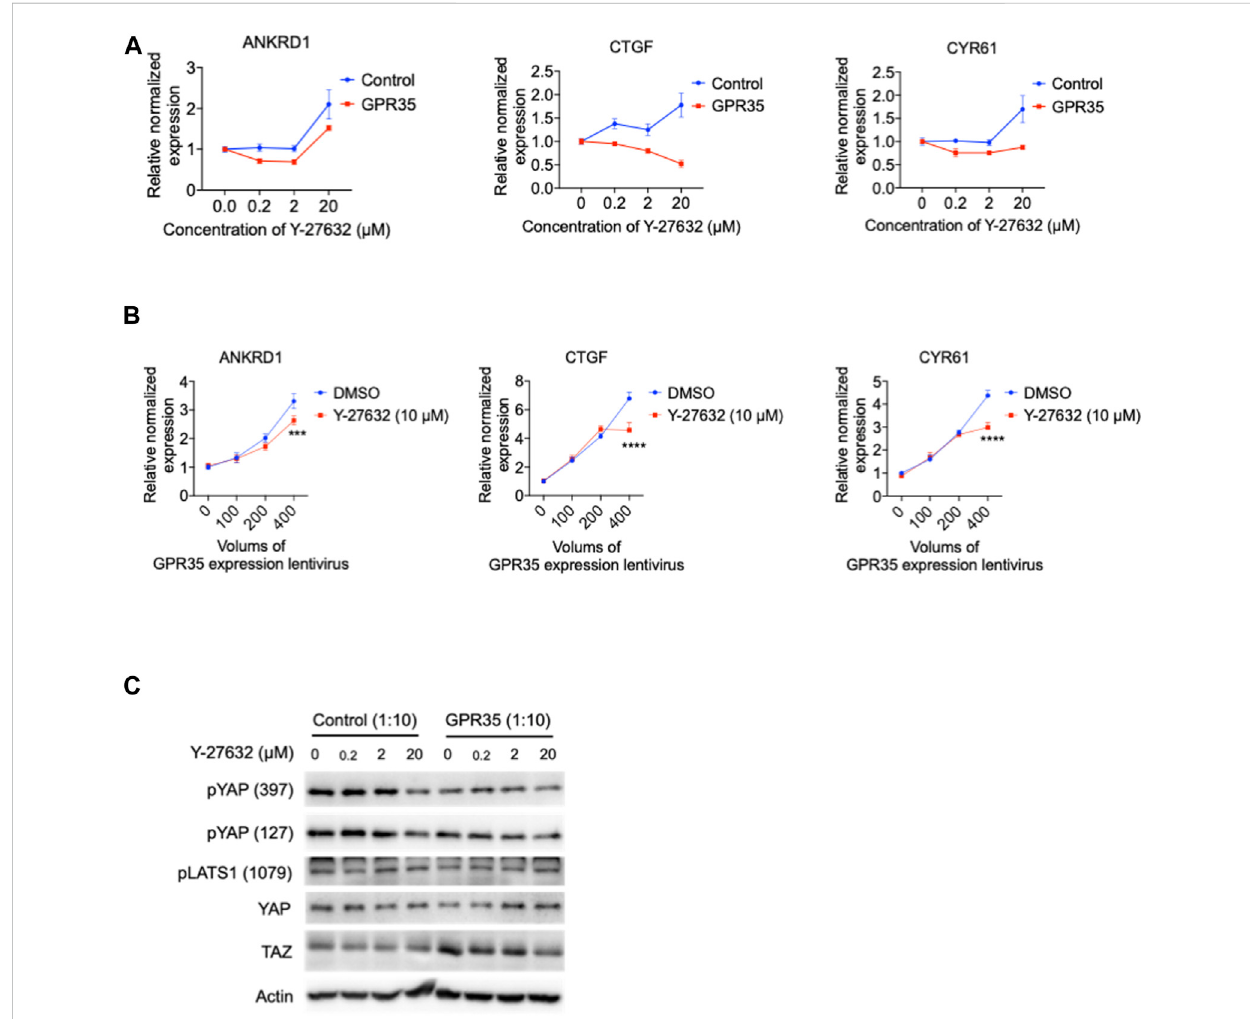
FIGURE 9 ROCK1 kinase inhibitor Y-27632 partly inhibited GPR35-mediated YAP/TAZ activity. 293FT cells were infected with GPR35 expression lentivirus at differentratiosof1:10for24 h,anddifferentconcentrationsofY-27632wereaddeddirectlytothemedium. (A) mRNAexpressionlevelofYAP/TAZtarget genes. (B) The mRNA expression of YAP/TAZ target genes. 293FT cells were infected with different volumes of GPR35 expression lentivirus for 24 h, and 10 μ MY-27632 wasaddeddirectlytothemediumforanother24 h.ThencellswereharvestedforPCRassay. (C) WesternblotassayonYAPandTAZ expression levels, phosphorylation levels, and LATS1 phosphorylation